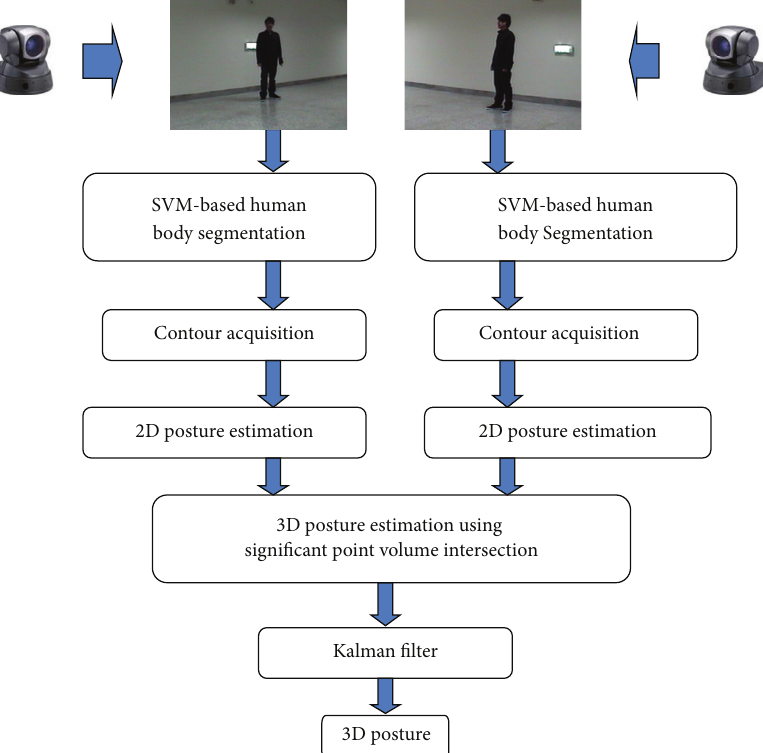
Figure 1: Flowchart of the proposed real-time 3D human model construction method using significant